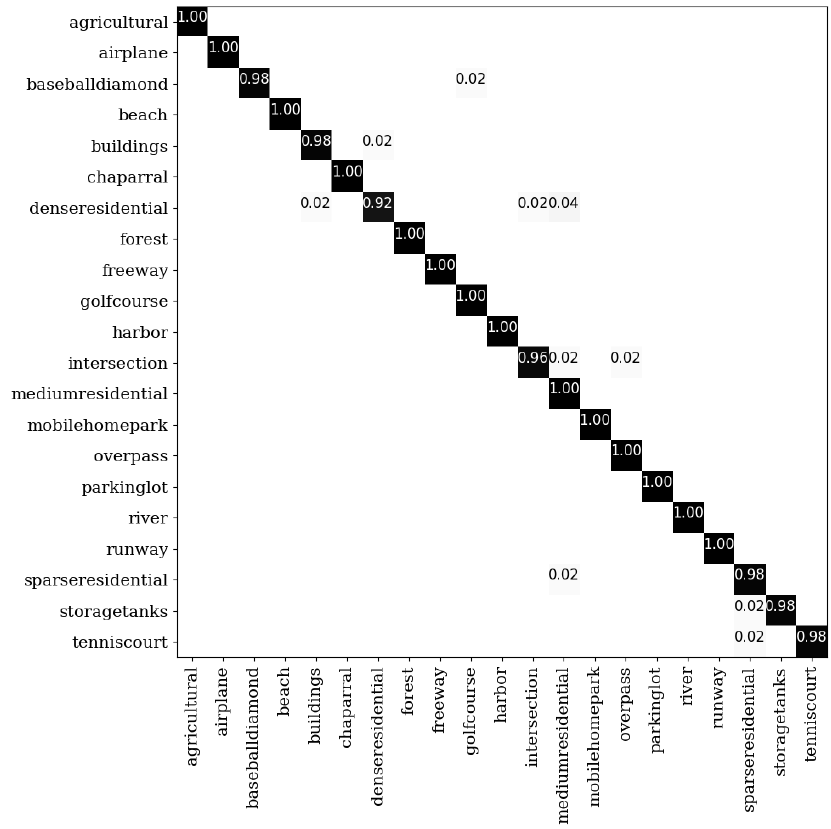
Figure 8. The confusion matrix on the UCM dataset under the 50% training samples.